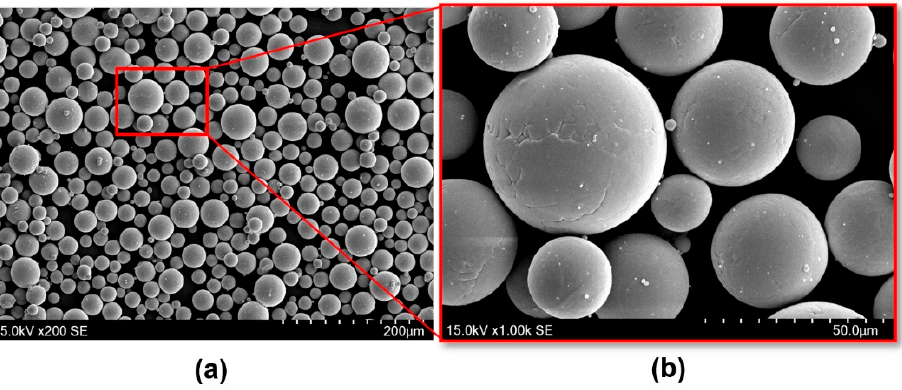
Figure 1. SEM image showing the morphology of spherical Ti6Al4V raw powder used for manufac- turing lattice structures via SLM ( a ) and powder’s surface appearance ( b ). Table 1. Particle size distribution and apparent density of Ti6Al4V powder used in this study .